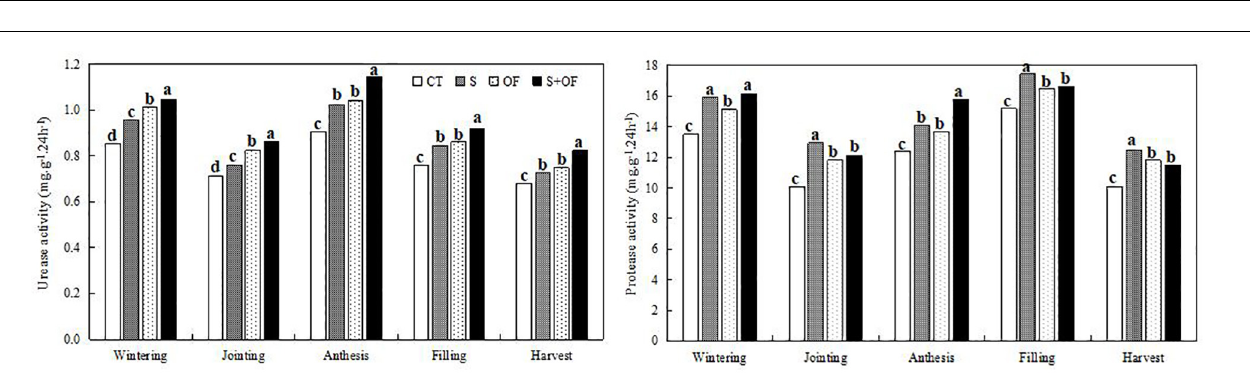
FIGURE 5 | Effects of subsoiling, organic fertilizer and subsoiling combined with organic fertilizer on urease activity and protease activity of soil at different growth stages of winter wheat in 2019. CT, conventional tillage; S, subsoiling; OF, organic fertilizer; S+OF, organic fertilizer combined with subsoiling. Different lowercase letters in the same growth stage indicate significant differences among treatments by LSD test ( P <